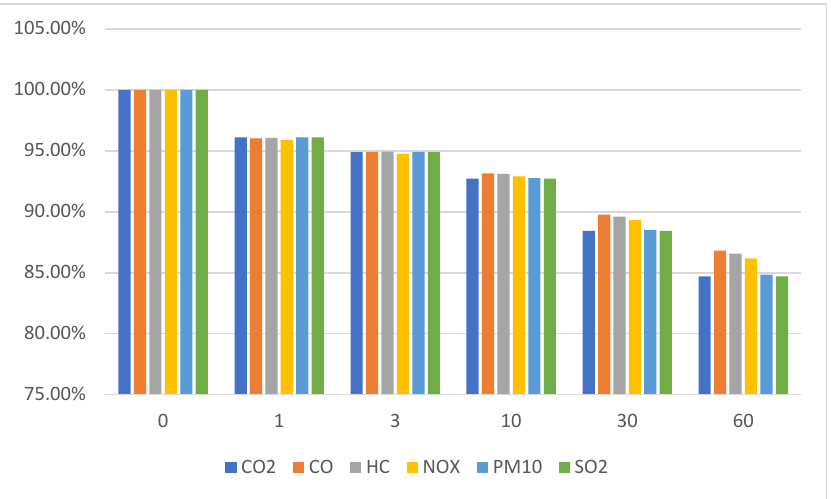
Figure 6. Ratios of the total emissions of CO 2 , CO, HC, NO X , PM10, and SO 2 for the six ships in one year with thinning at different time intervals and without thinning.